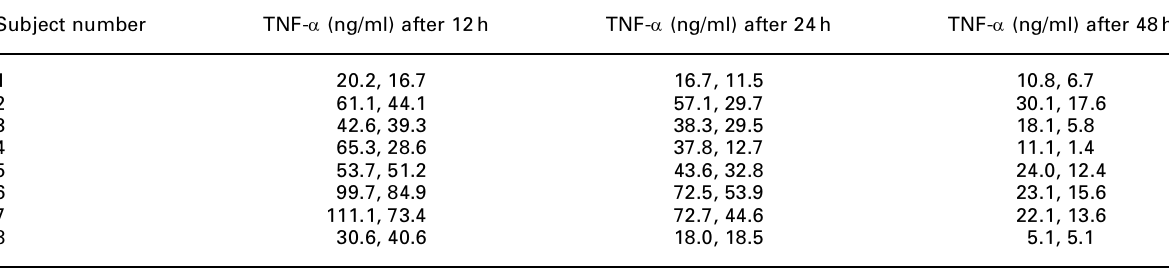
Table 1. Tumor necrosis factor- a (TNF- a ) concentrations in blood culture supernatants after 12, 24 and 48h of cultivation before and 24h after intake of 80mg aspirin in eight healthy women